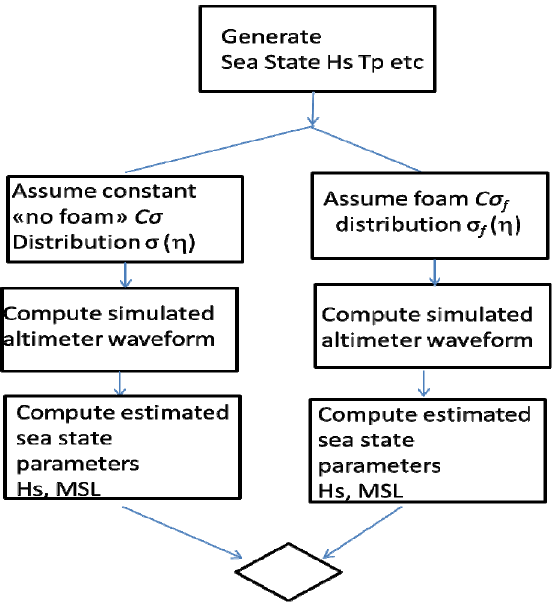
Figure 8. Procedure to compare the effects of the foam spatial distribution on sea state parameters.